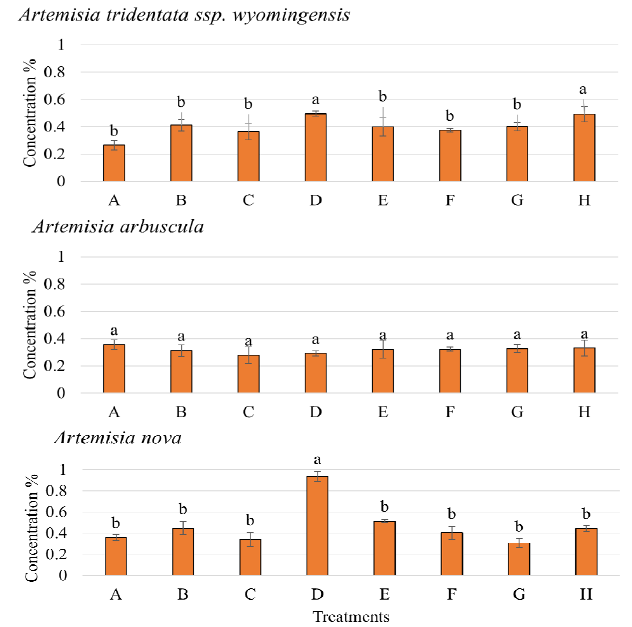
Figure 6. Phosphorus (P) concentration ± SE (error bars) in Artemisia tridentata ssp. wyomingensis , Artemisia arbuscula, and Artemisia nova and their associated Taeniatherum caput-medusae grown as competition. Different letters above bars indicate significant differences among treatments (Tukey’s HSD). P content of Artemisia species grown under competition not measured.